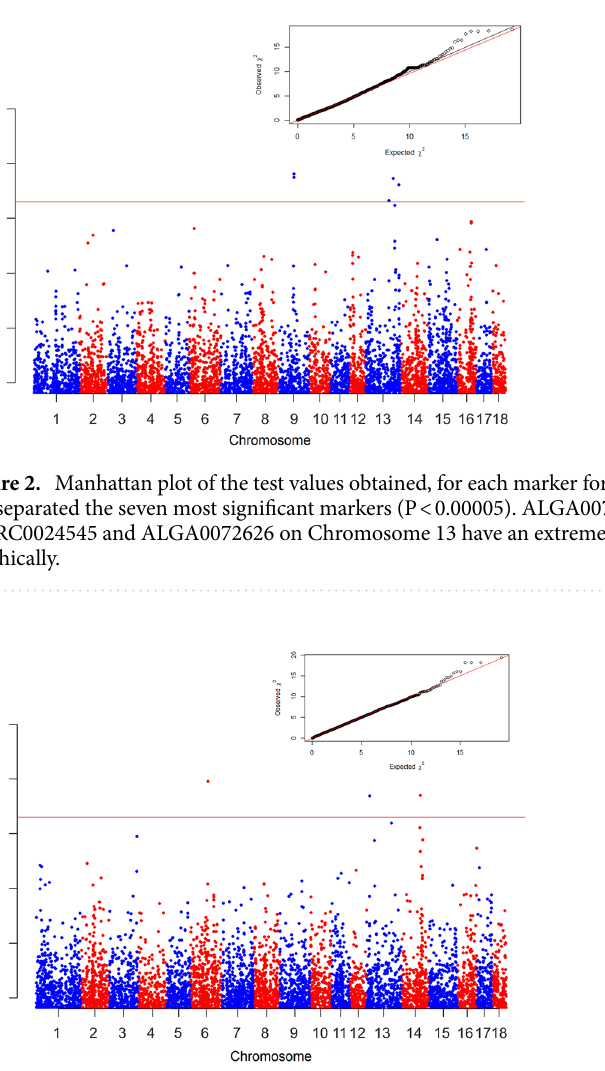
Figure 3. Manhattan plot of the test values obtained for Leptospira. The horizontal red line separated the four most significant markers (P < 0.00005). SNP H3GA0042130 and ASGA0066225 on Chromosome 14 have an extremely closed positions, difficult to separate